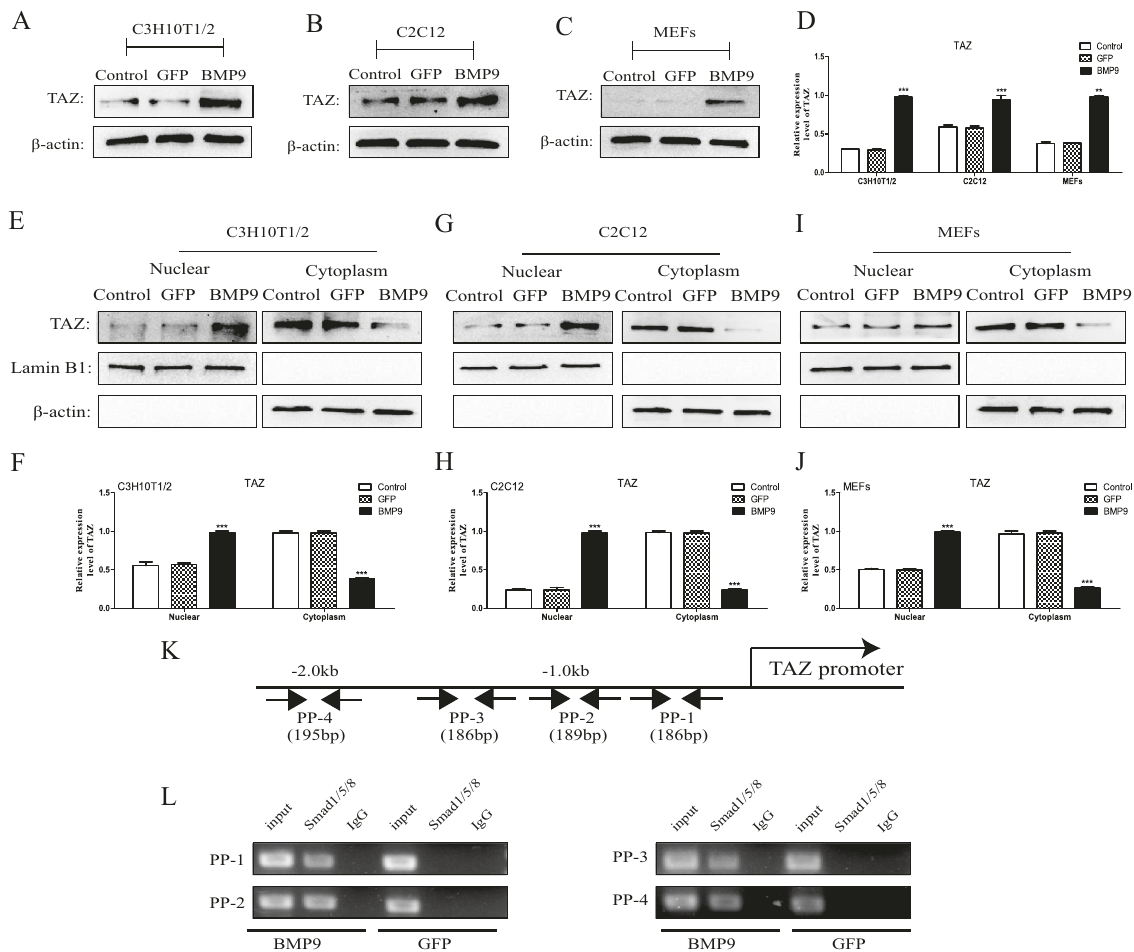
Fig. 1 The effects of BMP9 on TAZ expression in MSCs and MMCs, TAZ was a direct target of BMP9/Smad signaling. A – D The protein expression level of TAZ was detected by Western blot after Ad-BMP9 or Ad-GFP infection for 24 h. E – J The nucleoprotein and cytoplasmic protein expression levels of TAZ were detected by western blot after Ad-BMP9 or Ad-GFP infection for 24 h. K Prediction of Smad1/5/8 binding sites in the TAZ promoter region. L Enrichment of Smad1/5/8 on the PP-1, PP-2, PP-3, and PP-4 fragment of the TAZ promoter were measured by ChIP in MSCs. The data were shown as mean ± SD for three separated experiments. ( *P < 0.05 , **P < 0.01 , ***P < 0.001) MSCs mesenchymal stem cells, MMCs murine multi-lineage cells, ChIP chromatin immunoprecipitation, Ad-GFP adenovirus carrying green fl uorescent protein gene, Ad-BMP9 adenovirus carrying bone morphogenetic protein 9 gene, IgG immunoglobulin G, GAPDH, glyceraldehyde 3-phosphate- dehydrogenase, TAZ transcriptional co-activator with PDZ-binding (Fig. 4A, B). Compared with the BMP9 group, further quantitative analysis of bone histomorphology revealed that the values of TV, BV, BV/TV, BS, BS/BV, Tb.N, and Tb.Th were increased while Tb.Sp was decreased in the BMP9 + TAZ group. The results of the